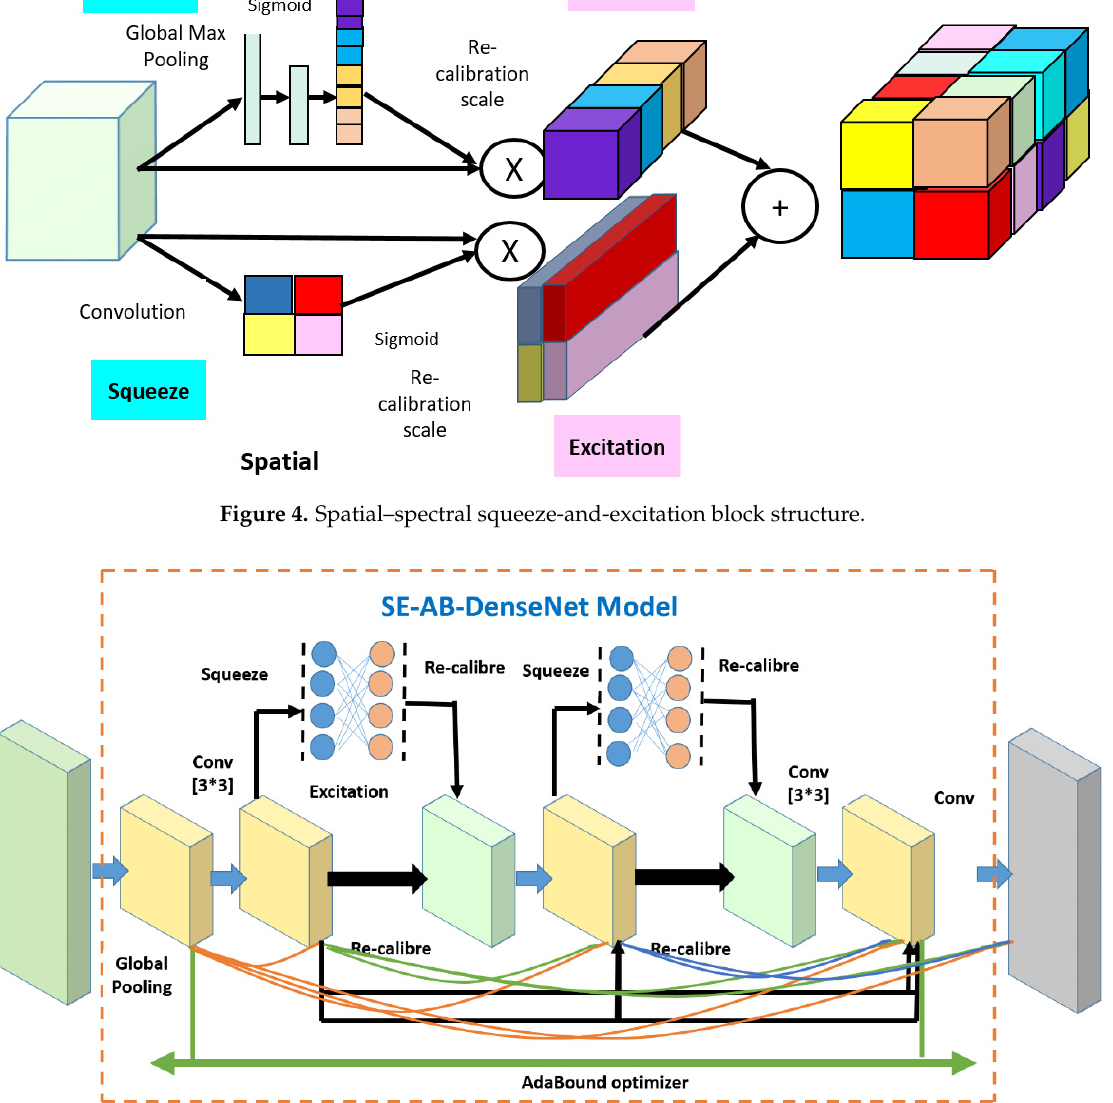
( b ) Figure 6. ( a ) Indian Pines dataset map; ( b ) color codes with scale bar (* is approximate scale of dataset).